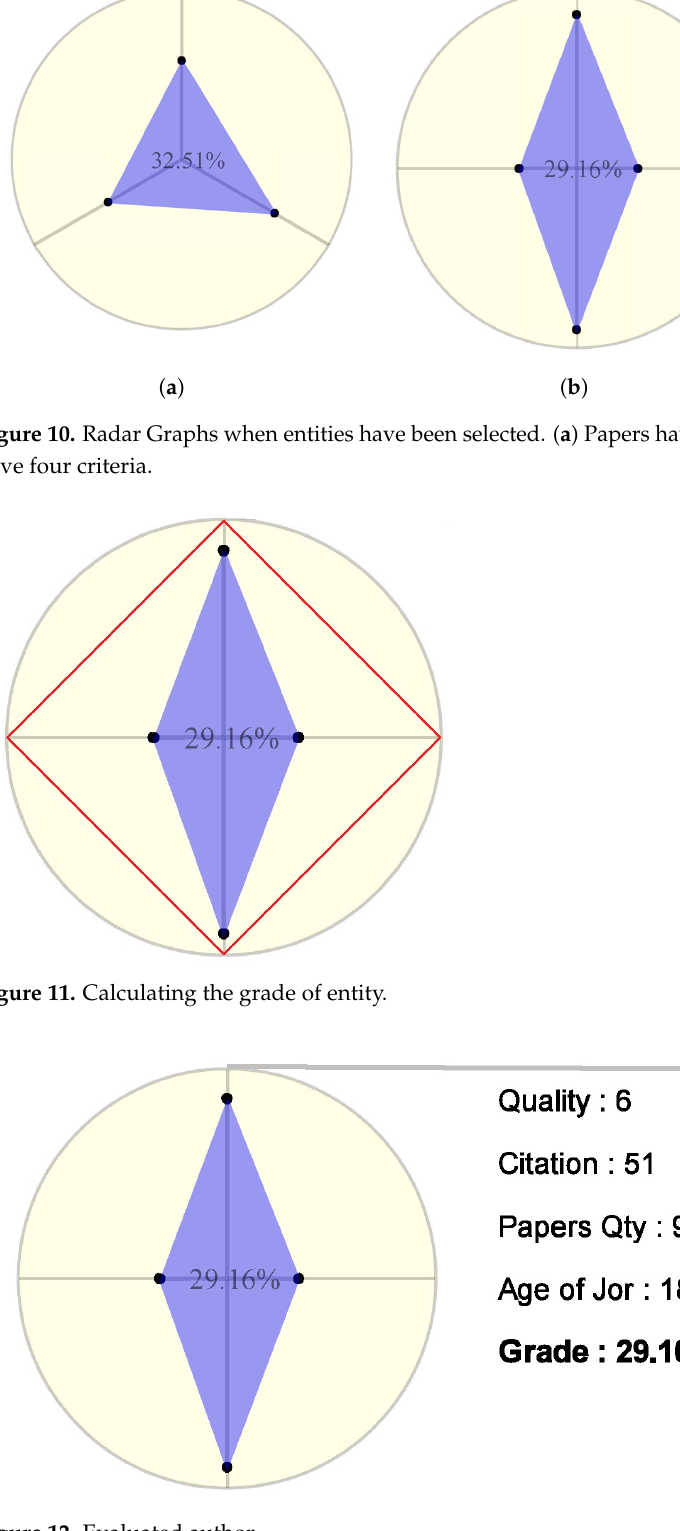
Figure 12. Evaluated